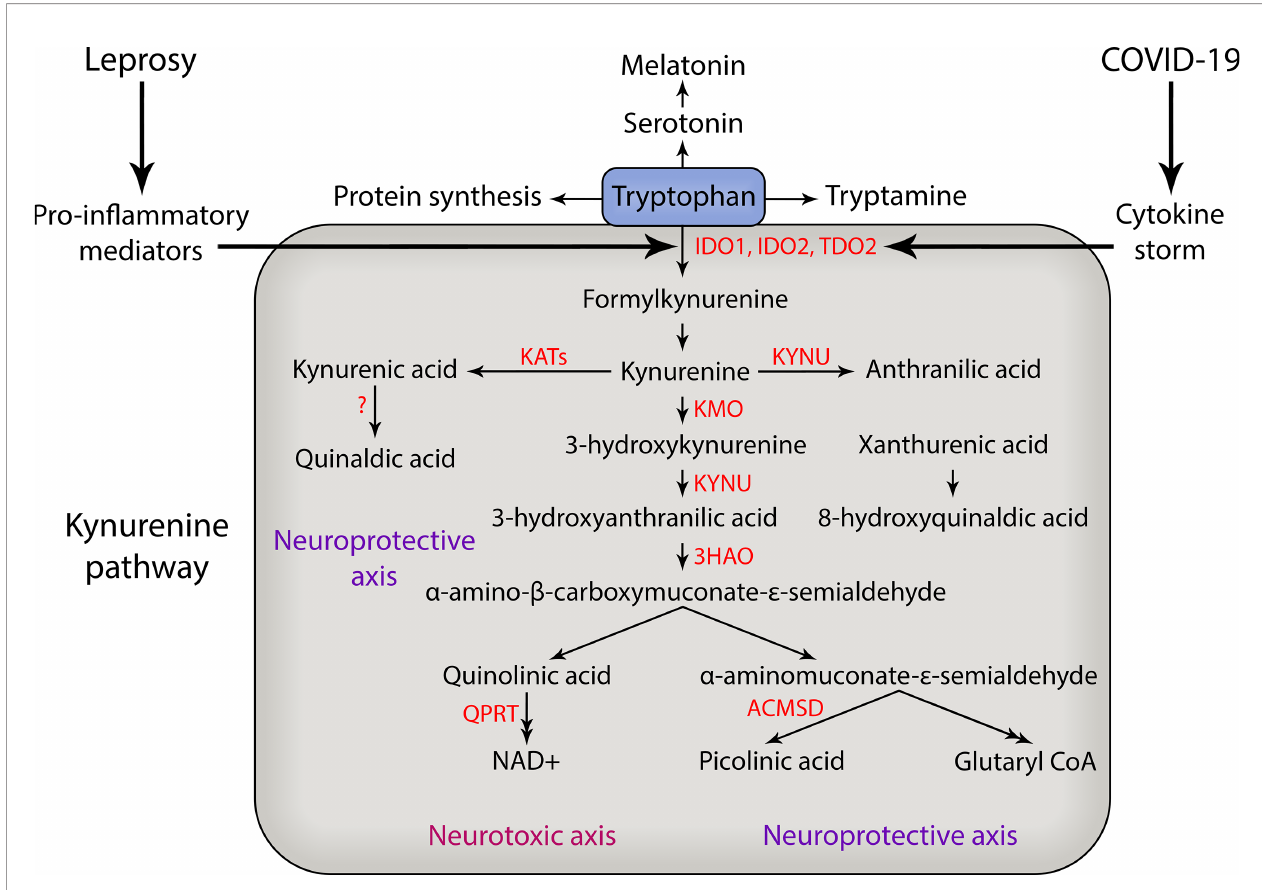
FIGURE 1 | Kynurenine pathway of tryptophan degradation in leprosy and COVID-19. During the course of severe COVID-19 and leprosy immunological reactions there is an increase in production of pro-in fl ammatory mediators such as TNF, IL-6 and IL-1 b that may activate the enzymes that catabolize tryptophan and generate neuroactive kynurenine metabolites that can contribute to peripheral nerve damage and the development of chronic pain. In addition, the cytokine storm that occurs during COVID-19 can also trigger neuropathy and reactional episodes in leprosy patients. The main kynurenine pathway enzymes are shown in red. IDO, indoleamine 2,3-dioxygenase; TDO, tryptophan 2,3-dioxygenase; KATs, kynurenine aminotransferases; KYNU, kynureninase; KMO, kynurenine 3-monooxigenase; 3HAO, 3- hydroxyanthranilic acid dioxygenase; QPRT, quinolinic acid phosphoribosyltransferase; ACMSD, aminocarboxymuconate-semialdehyde decarboxylase; NAD, nicotinamide adenine dinucleotide; CoA, coenzyme